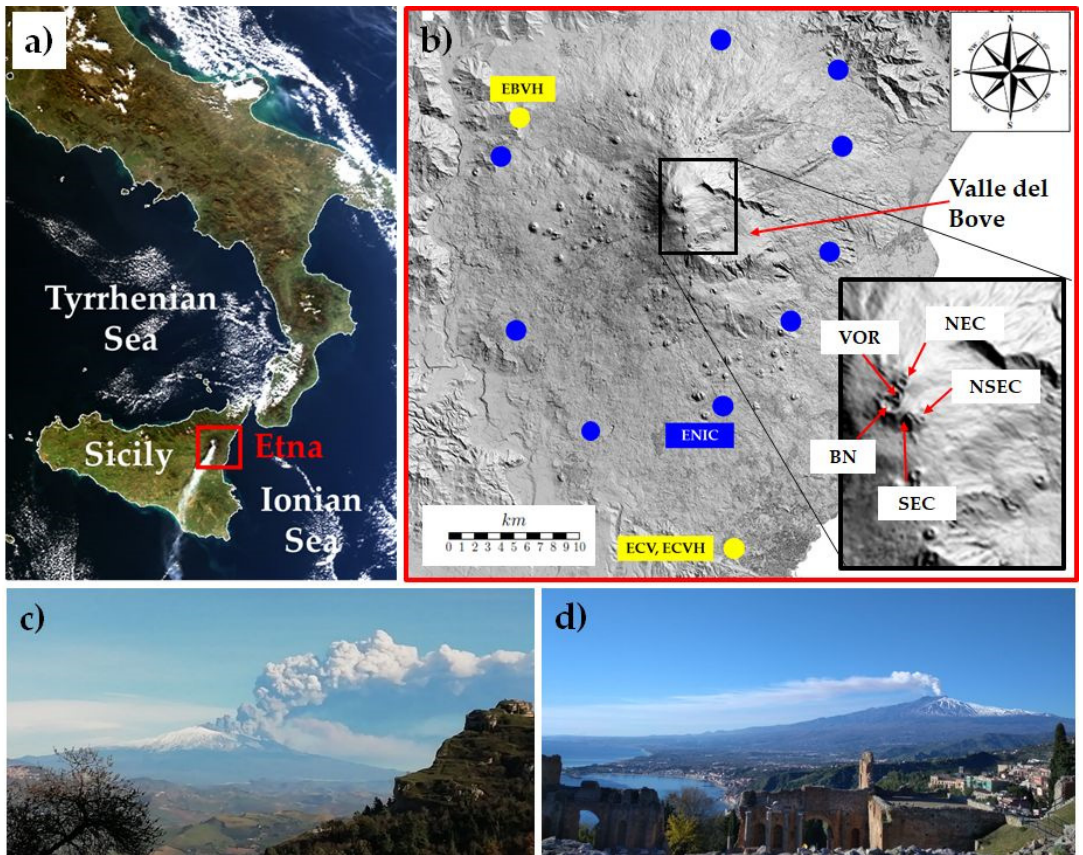
Figure 1. ( a ) Image of southern Italy collected from the MODerate resolution Imaging Spectroradiometer (MODIS) satellite sensor on board the Terra/Aqua NASA satellites on 27 December 2018 at 12:20 UTC. The Etna location is identified by the red square. ( b ) Map of Etna volcano with the indication of the visible cameras (yellow points) and FLux Automatic MEasurements (FLAME) spectrometers (blue points) used in this work for the products’ validation. In the zoom, the main active craters are indicated: Voragine (VOR), Bocca Nuova (BN), North East Crater (NEC), South East Crater (SEC), and New SEC (NSEC). ( c , d ) Etna activities of 24 and 27 December 2018 seen from Enna and Taormina, respectively (photo credits Truscia and Ponzo).